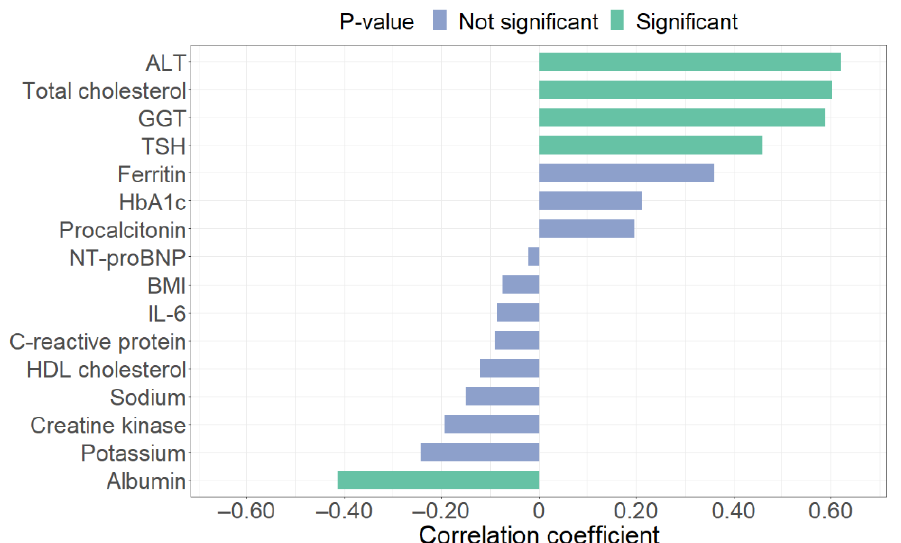
Figure 2. Spearman correlation coefficients between clinical and biochemical parameters and tri- glyceride – glucose (TyG) index. ALT: alanine transaminase; GGT: gamma-glutamyl transferase; TSH: thyroid-stimulating hormone; HbA1c: glycated hemoglobin; NT-proBNP: N-Terminal pro-Brain Natriuretic Peptide; BMI: Body Mass Index; IL-6: interleukin-6. Overall, the average glucose value is 105 mg/dL (±16 mg/dL SD). Figure 3 shows the mean percent partition of time spent within different glucose ranges. Average TIR is 93.76% (±9.94% SD) with 9.42% (±14.86% SD) of glucose readings in the 141 – 180 mg/dL range (dark green bar). Time spent outside the 70 – 180 mg/dL range is highly asymmet- rical: average TBR is 5.67% (±10.19% SD), with only 0.30% (±0.64% SD) of glucose read- ings (orange bar) under the 54 mg/dL threshold of severe hypoglycemia, while average TAR (red bars) is 0.57% (±1.20% SD).